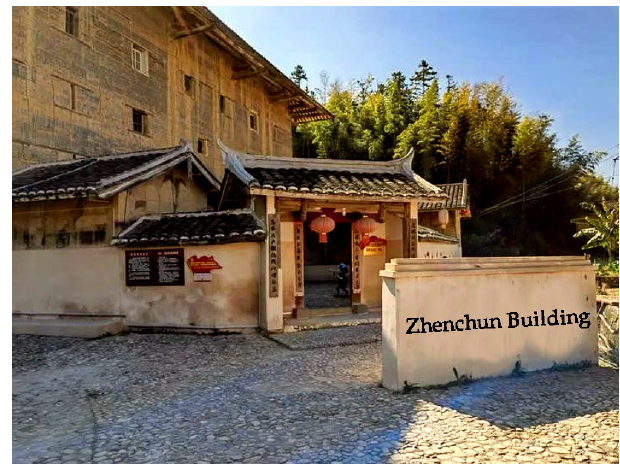
Figure 4. The Zhenchun Building.